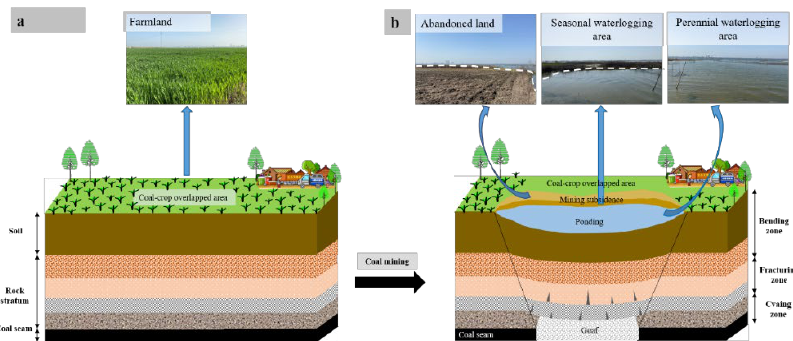
Figure 10. Mechanism of farmland damage in COA. ( a ) Crops grow normally before coal mining. ( b ) Damaged cropland with altered landscape patterns after coal mining.